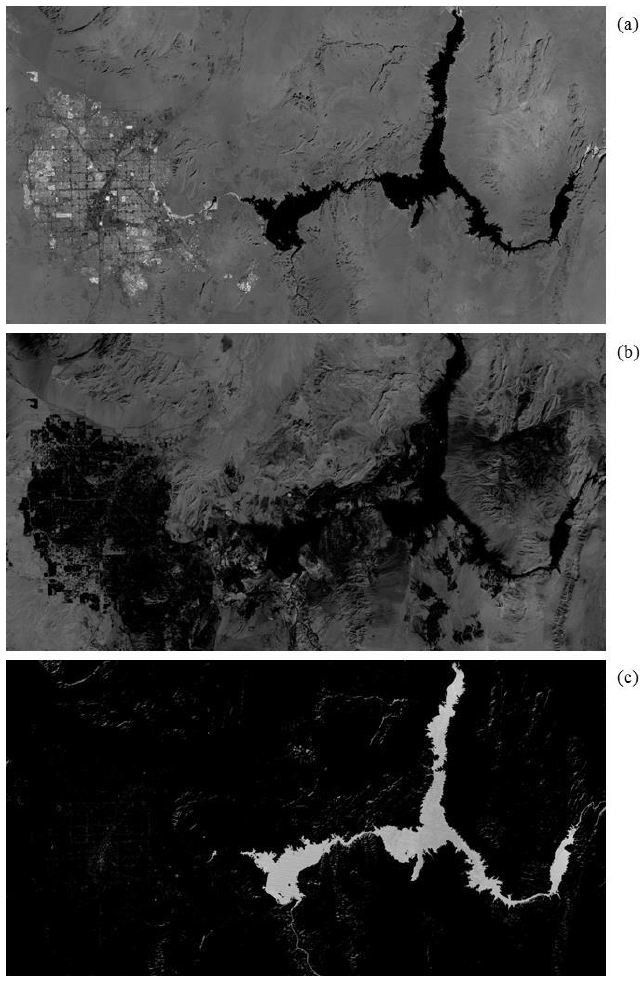
Figure 4. Example indices generated from Landsat TM over Las Vegas: ( a ) NDVI; ( b ) NDBI; ( c )